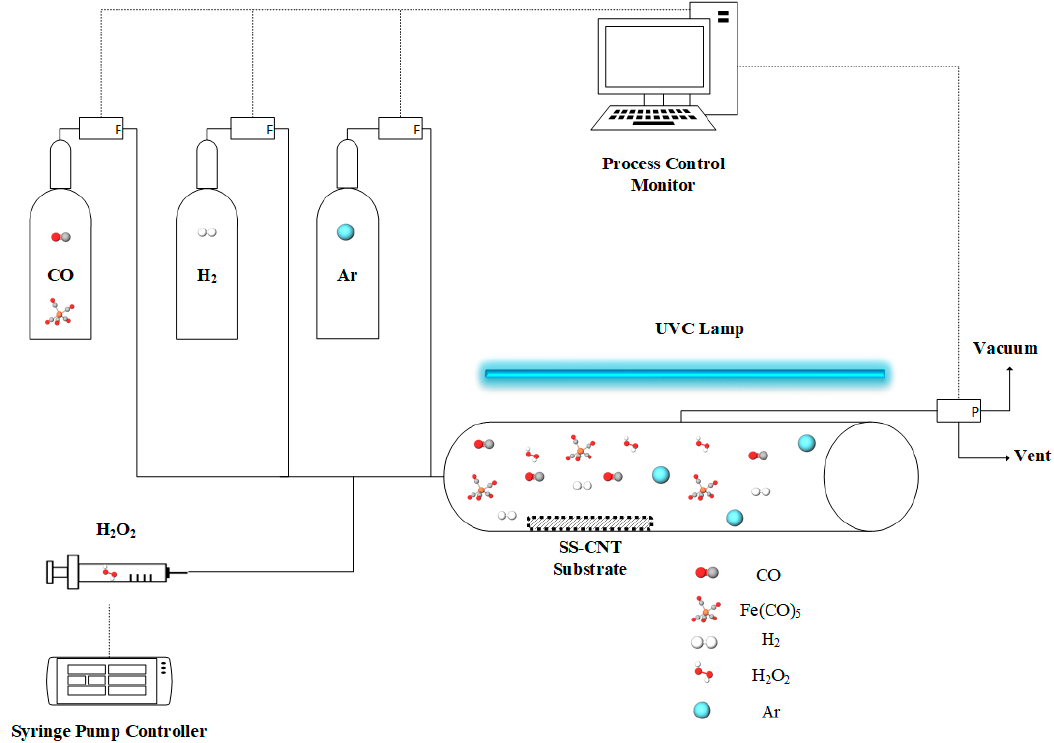
Figure 6. PICVD experimental setup. Figure 6. Photo-initiated chemical vapor deposition (PICVD) experimental